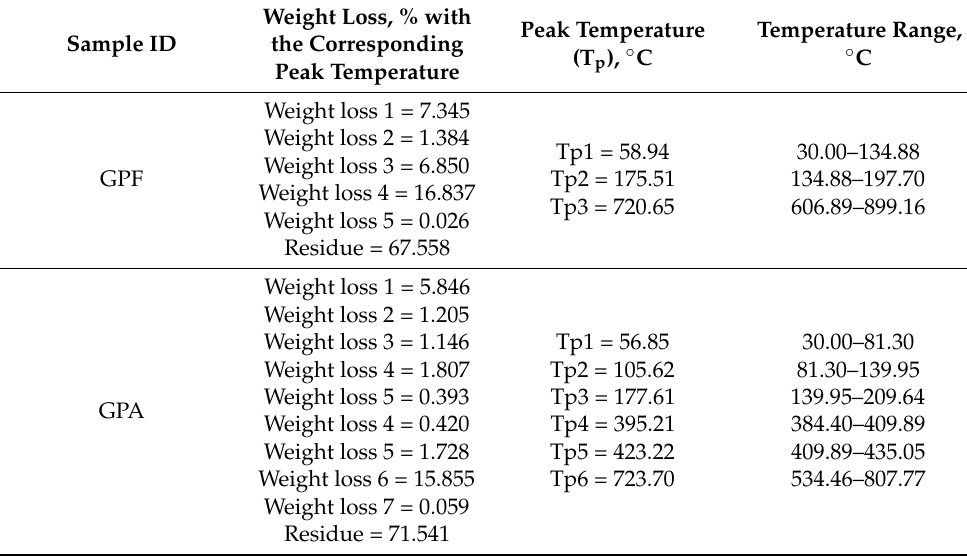
Table 2. TG-DTA data of the geopolymer composites.